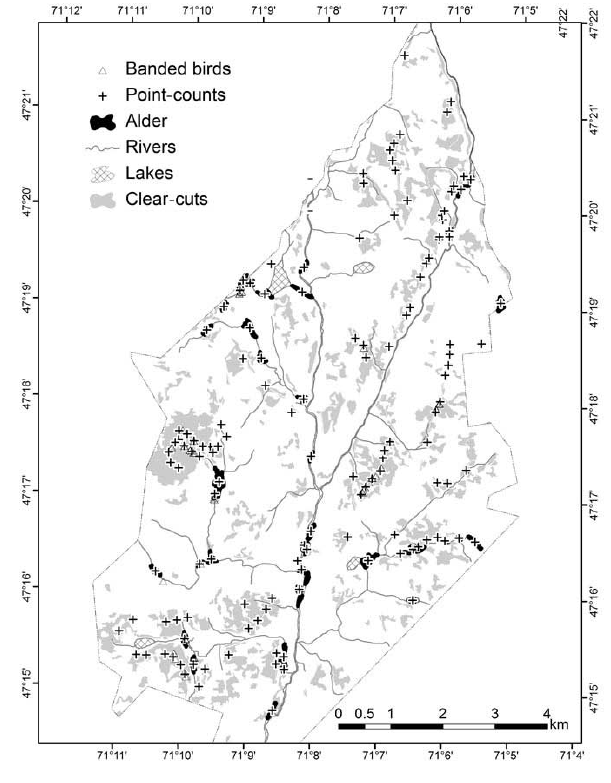
Fig. 1 . Forót Montmorency and locations of alder ( Alnus spp.) and clear-cut (< 15 y) patches and point-count sites. Forót Montmorency is located 60 km north of Québec city,